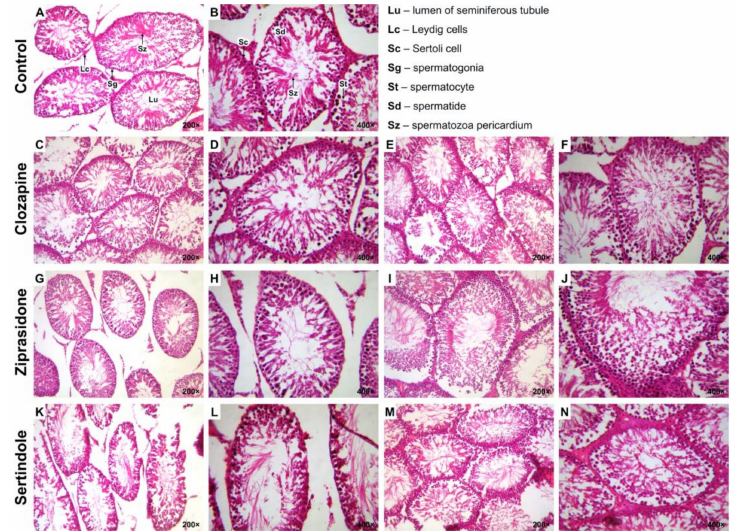
Figure 2. Photomicrographs of rat testicular tissue structure, H&E stain. Control group–( A ) and ( B ): normal seminiferous tubular morphology (Johnsen score 10); Lu–lumen of seminiferous tubule, Lc– Leydig cells, Sc–Sertoli’s cell, Sg–spermatogonia, St–spermatocyte, Sd–spermatid, Sz–spermatozoa (( A ): 200 × ; ( B ): 400 × ). Clozapine-treated group–( C ) and ( D ): less than five spermatozoa per tubule, a few late spermatids (Johnsen score 8); ( E ) and ( F ): slightly impaired spermatogenesis with many late spermatids and disorganised epithelium (Johnsen score 9) (( C ) and ( E ): 200 × ; ( D ) and ( F ): 400 × ). Ziprasidone-treated group–( G ) and ( H ): less than five spermatozoa per tubule, a few late spermatids (Johnsen score 8); ( I ) and ( J ): slightly impaired spermatogenesis with many late spermatids and disorganised epithelium (Johnsen score 9) (( E ) and ( G ): 200 × ; ( F ) and ( H ): 400 × ). Sertindole-treated group– ( K ) and ( L ): seminiferous tubule with few germinal cells and pyknotic nuclei and extensive disorganisation (Johnsen score 6); ( M ) and ( N ): seminiferous tubule with no late spermatids, many early spermatids (Johnsen score 7) (( K ) and ( M ): 200 × ; ( L ) and ( N ): 400 × ).